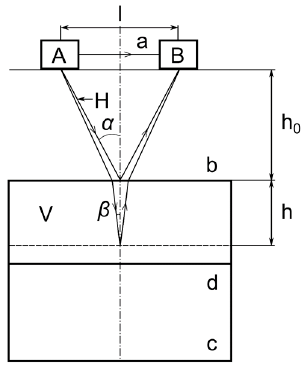
Figure 1. Scheme of the GPR experiment.